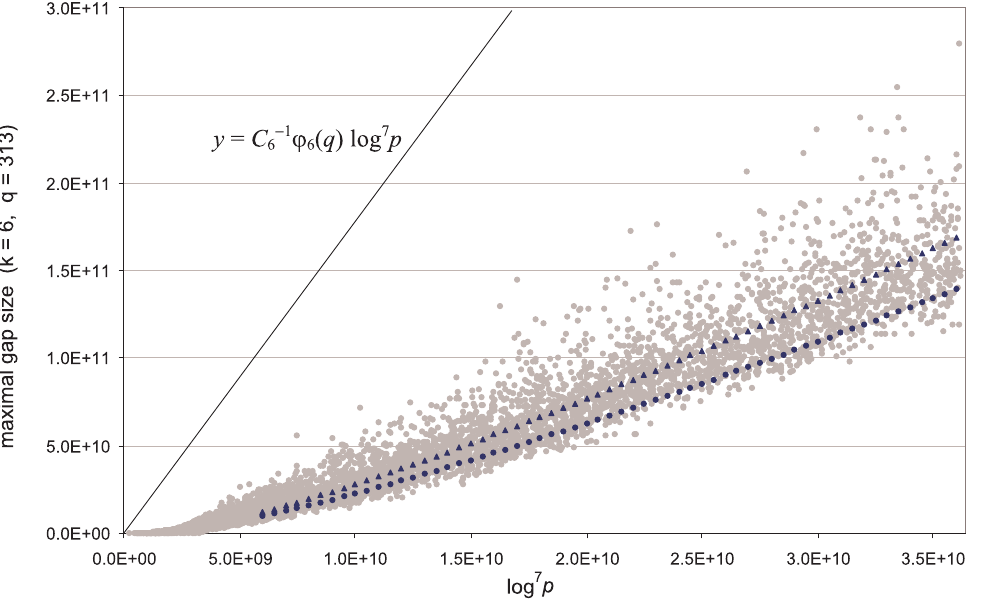
ϕ 6 ( q ) log 7 p 6